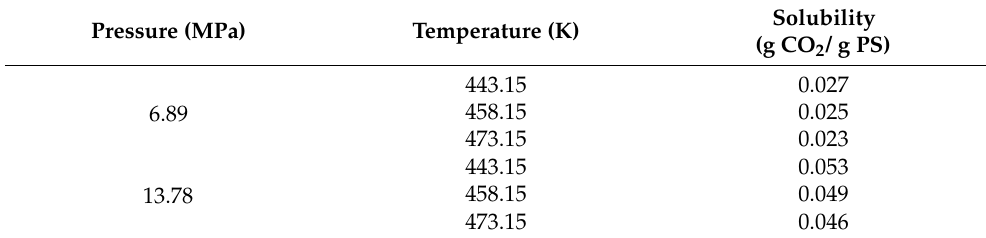
Table 5. Solubilities for CO 2 in PS at various temperatures and